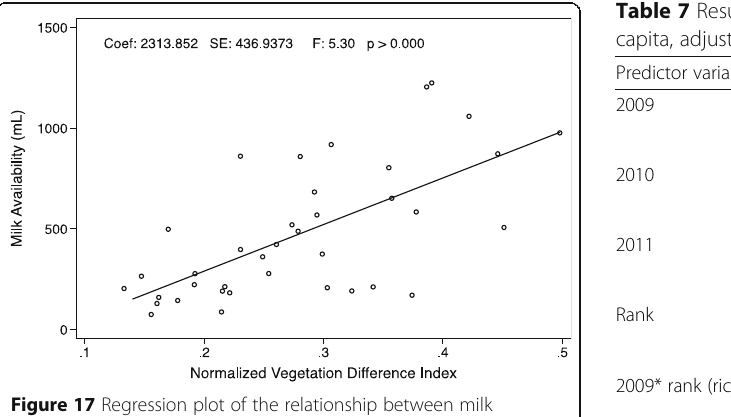
Table 7 Results of linear regression of large stock milk yield per capita, adjusted for lactating herd size and family size Predictor variable